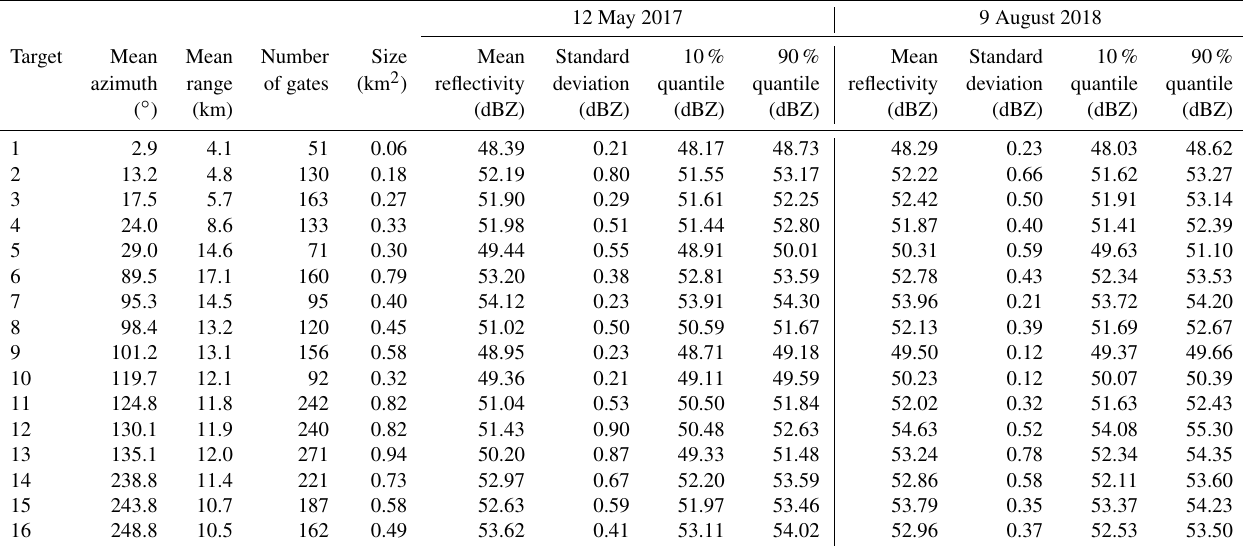
Table 3. Geometrical characteristics and apparent reflectivity statistics for the 16 mountain targets selected for the XPORT radar at an elevation angle of 7.5 ◦ . The mean, standard deviation, and 10% and 90% quantiles of the apparent reflectivity time series are given for the first and last convective events in the considered period (see Table 2).